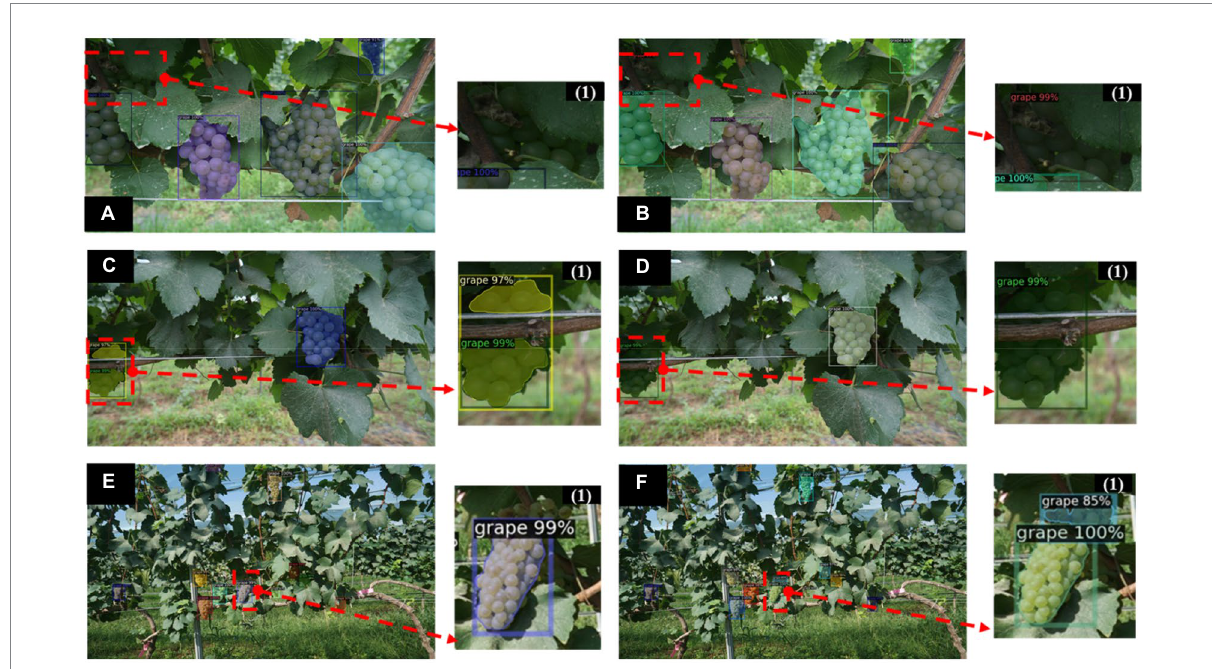
FIGURE 11 Effects of different natural environmental conditions on the performance of the improved Mask R-CNN. (A,C,E) are the predictions of the original Mask R-CNN under low light, occlusion and overlapping grape clusters in smooth light, respectively. (B,D,F) are the predictions of the improved Mask R-CNN under low light, occlusion and overlapping grape clusters in smooth light, respectively. (1) is partial enlargements of the instance segmentation results of the corresponding images.